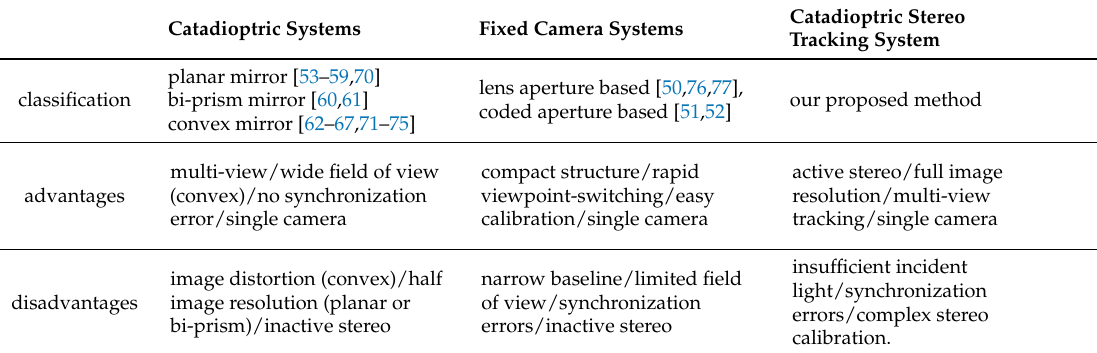
Table 2. Pros and cons of catadioptric stereo systems, fixed camera systems, and catadioptric stereo tracking